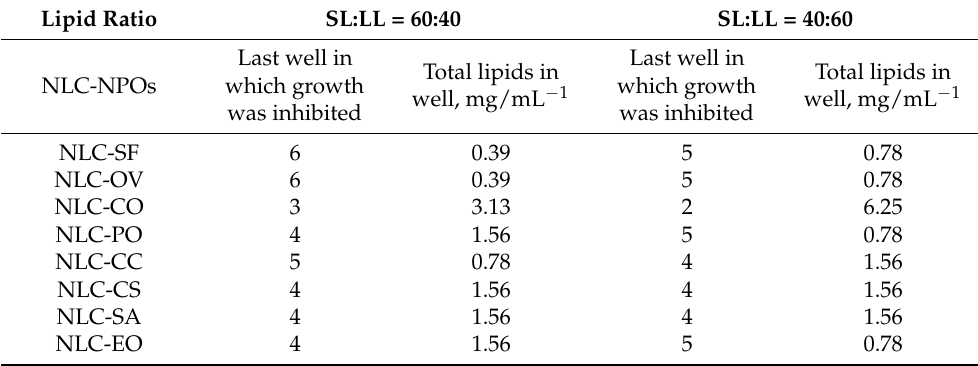
Table 6. Antimicrobial effect of NLC-NPO on S. aureus